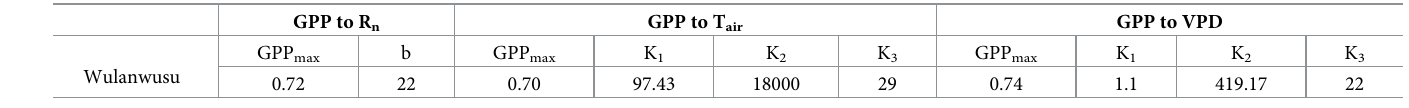
Table 1. Parameters of the responses of the GPP against environmental factors.